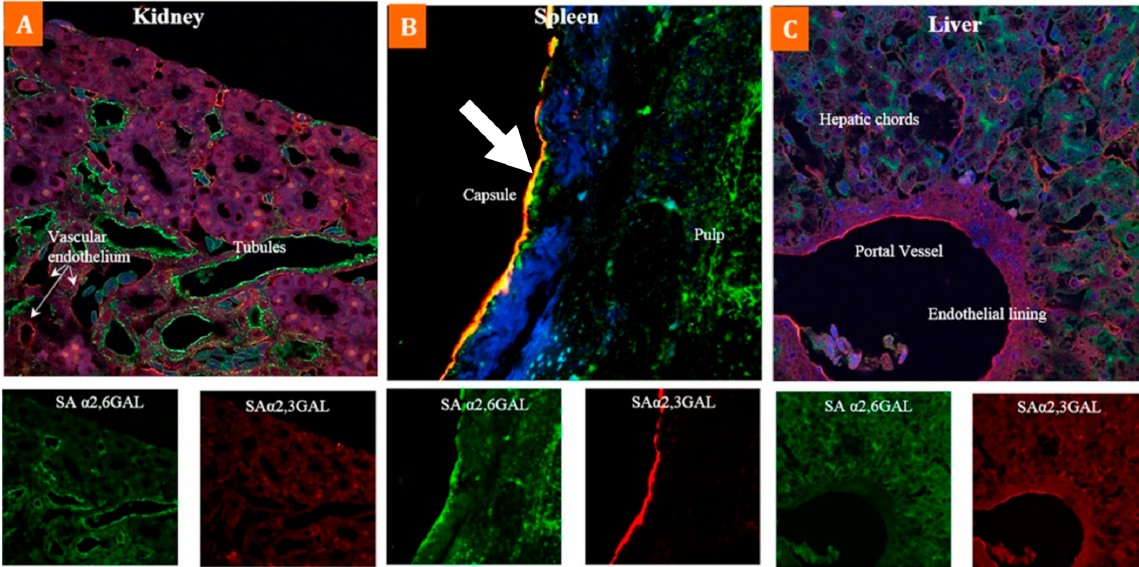
Figure 3. Abundant co-expression of α -2,3 SA and α -2,6 SA receptors in internal organs of the emu for ( A ) kidney, ( B ) spleen and ( C ) liver. Substantial yellow colouring of the spleen capsule lining indicates an abundance of cells with both types of SA receptors (white arrow). Tissue sections stained with biotinylated MAAII (red-specific for α -2,3-Gal SA) and FITC labelled SNA (green-specific for α -2,6-Gal SA) lectins, and nuclear staining with DAPI (blue). Adapted with permission from ref. [60]. Copyright 2017